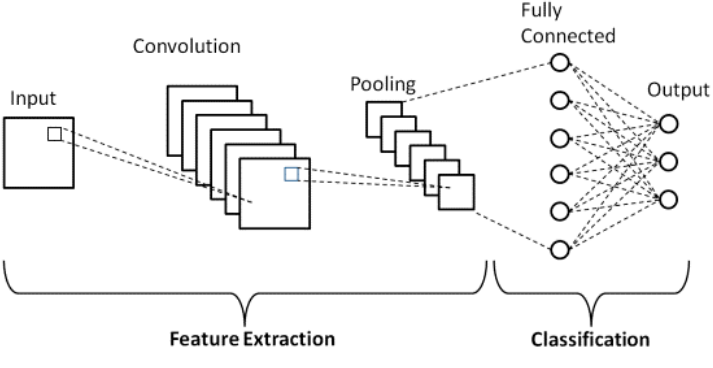
Figure 7. CNN basic architecture [51].